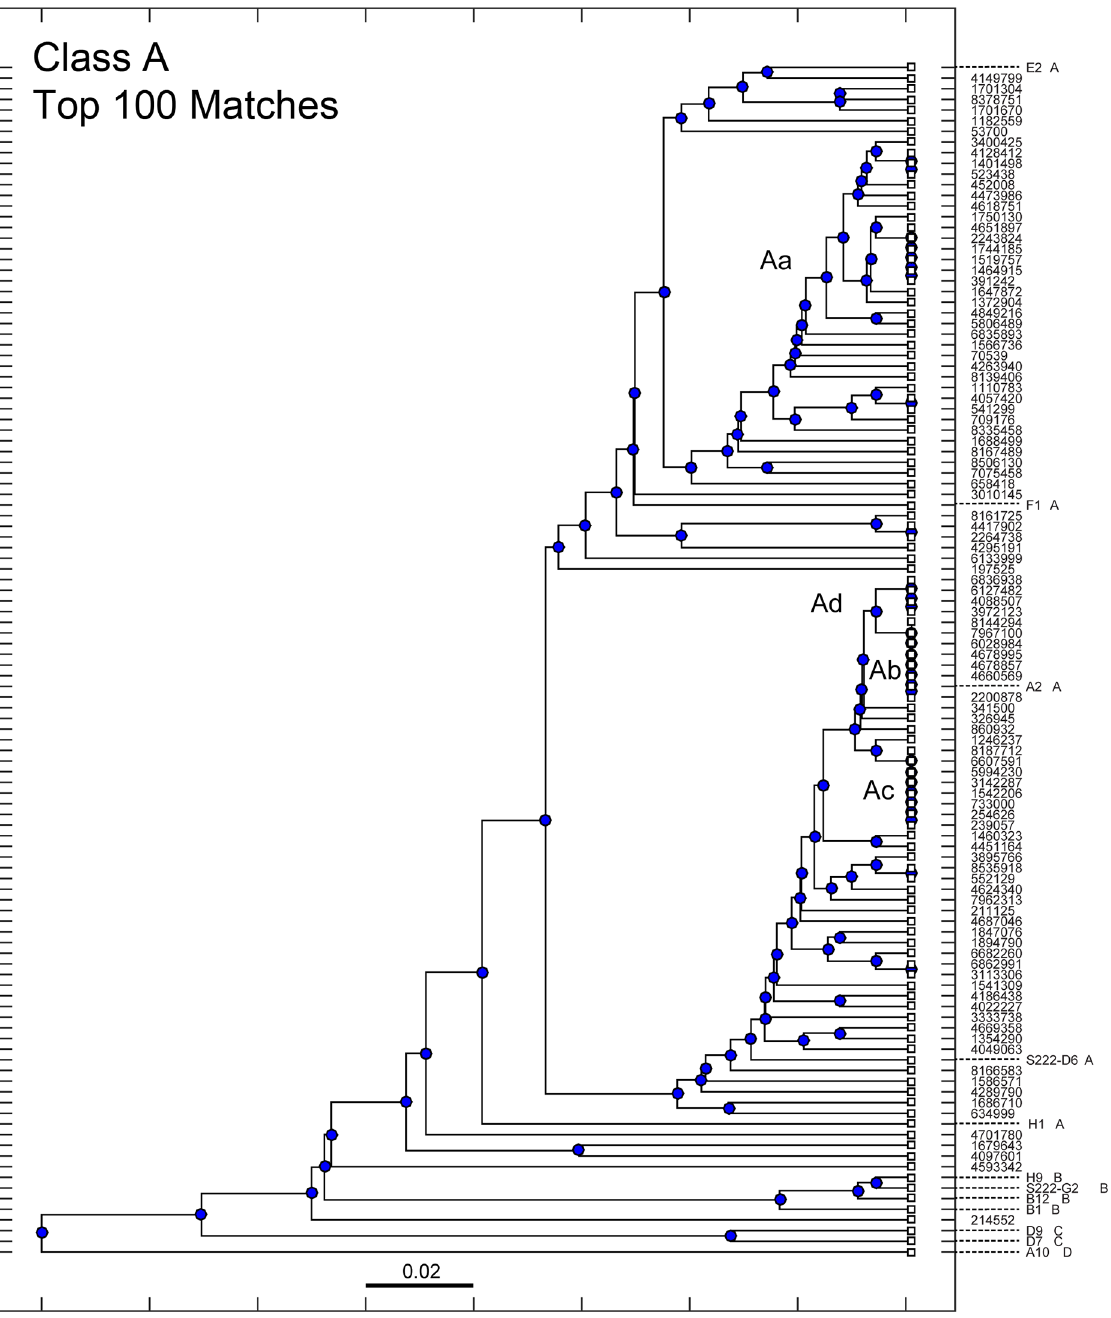
Fig 3. Phylogenetic tree of the top 100 sequences for Class A. Library sequences obtained in a search query using sequences from Class A were arranged in a phylogenetic tree denoting sequence similarity. The scale bar represents a 2% difference in the amino acid sequence. Previously identified sequences in Classes A through D were included, and denoted appropriately within the tree. Sequences from the library present in multiple copies are denoted as Aa, Ab, Ac, Ad.